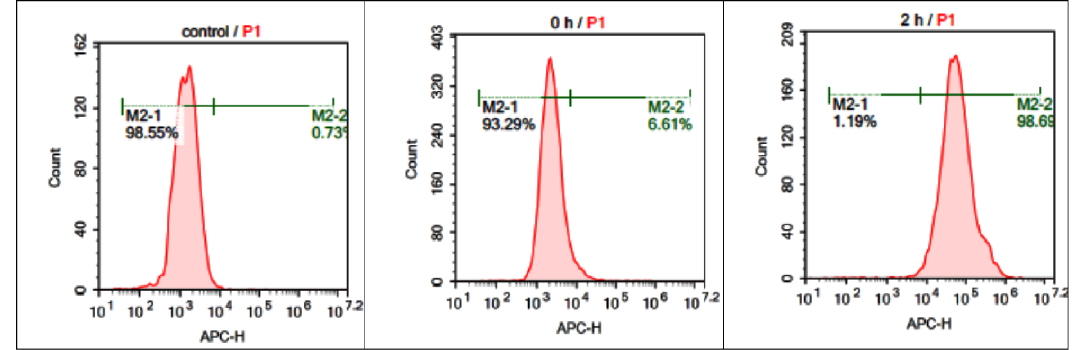
Figure 4. In vitro cellular uptake of HSA-Cy5-HcyTFAc-B 12 H 11 by T98G cells measured by flow cytometry. Red color: FACS analysis; green color: percent cellular uptake of HSA-Cy5 and HSA-Cy5-HcyTFAc-B 12 H 11 . The data were normalized to nontreated cells (control).